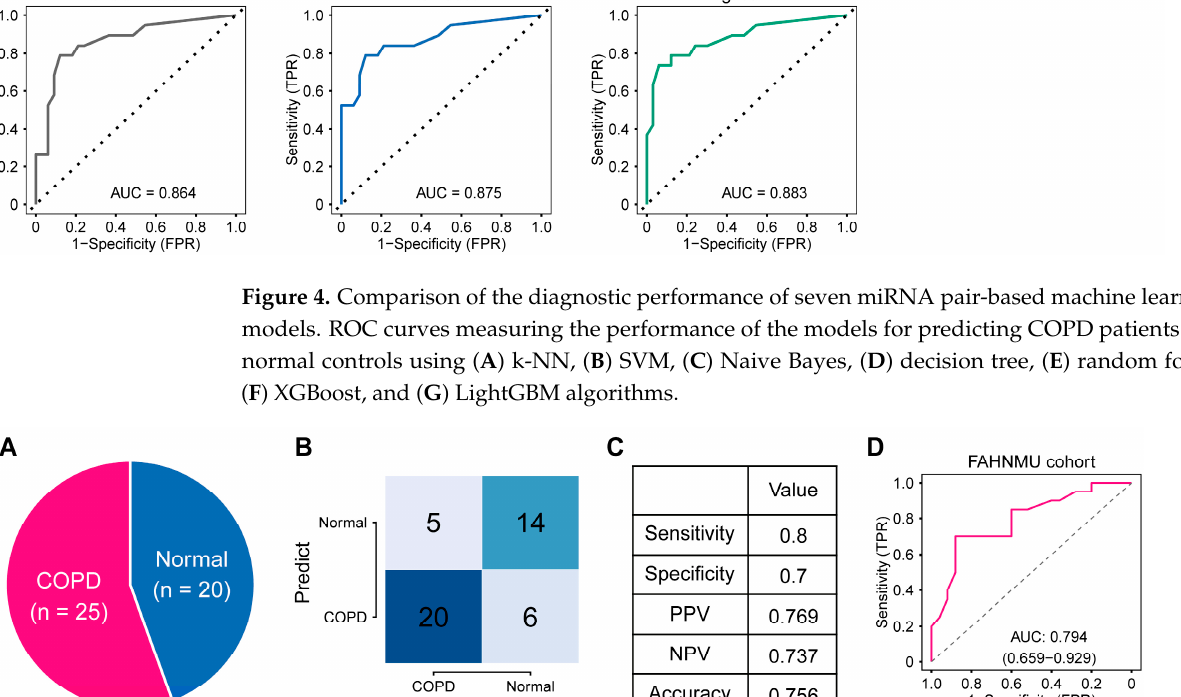
Figure 4. Comparison of the diagnostic performance of seven miRNA pair ‐ based machine learning models. ROC curves measuring the performance of the models for predicting COPD patients and normal controls using ( A ) k ‐ NN, ( B ) SVM, ( C ) Naive Bayes, ( D ) decision tree, ( E ) random forest, ( F ) XGBoost, and ( G ) LightGBM algorithms.